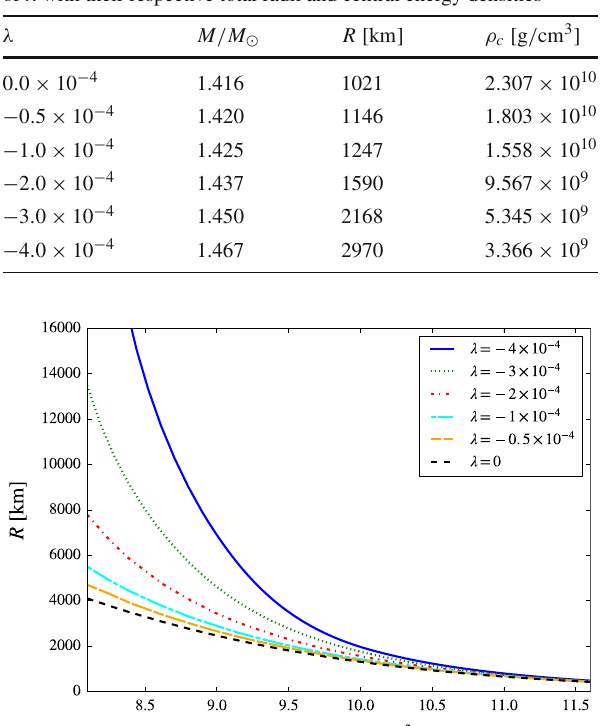
results. This is mainly due to the fact that the sound velocity becomes very small near the surface of the star, so that the term (19) weakens the gradient of pressure, yielding to the predicted larger